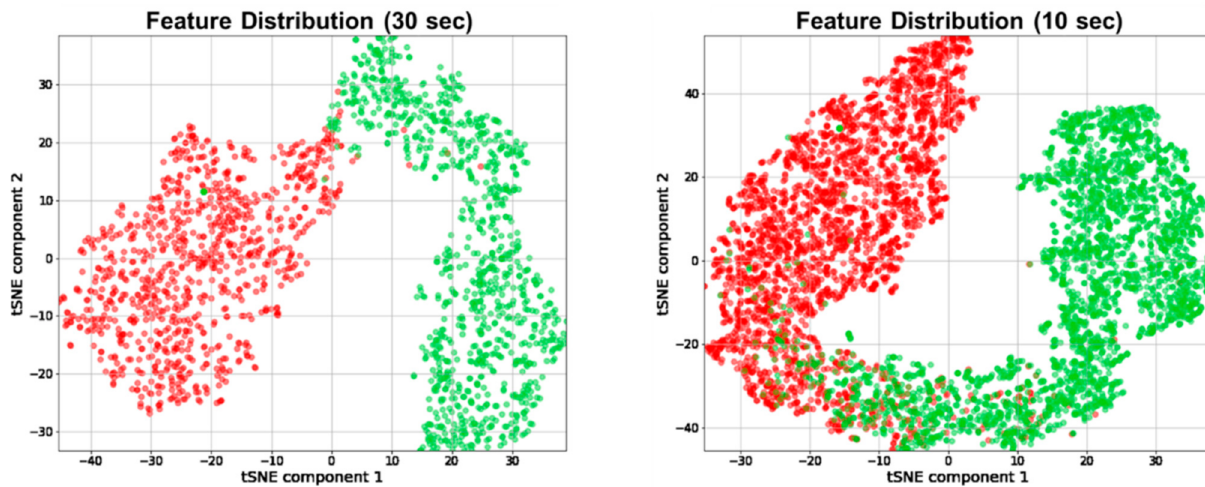
Figure 9. Distribution of our learned representation vectors embedded in two-dimensional vector space learned from FGSR, HGSR, and HR signals (red: stressed, green: